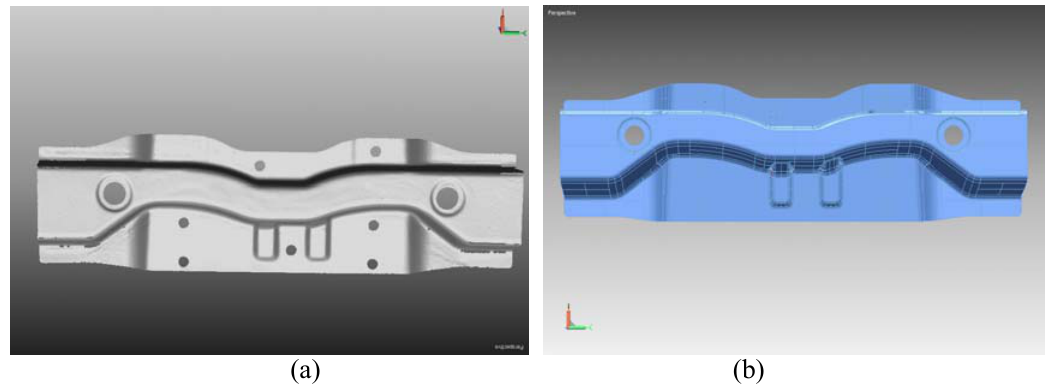
Figure 9. (a) STL data of scanned model, (b) 3D CAD surface model of the scanned sheet metal part.